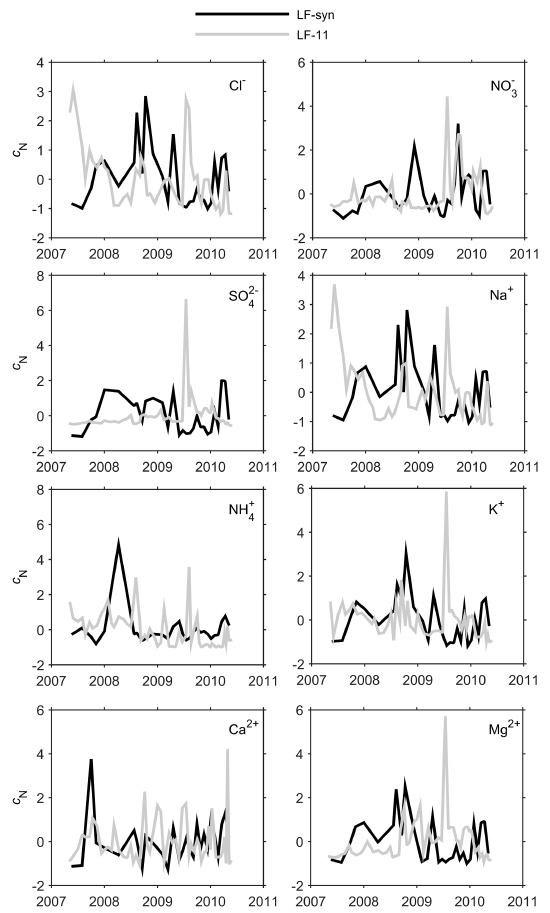
Figure 7. Comparison between a synthetic ice core (LF-syn, black) and the LF-11 ice core (grey). Ionic concentrations are normalized ( c N ) to mean values according to the LF-syn ice core time scale.